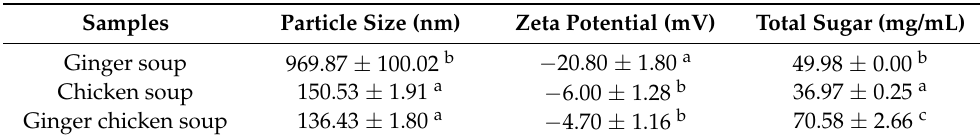
Table 1. Component analysis of different